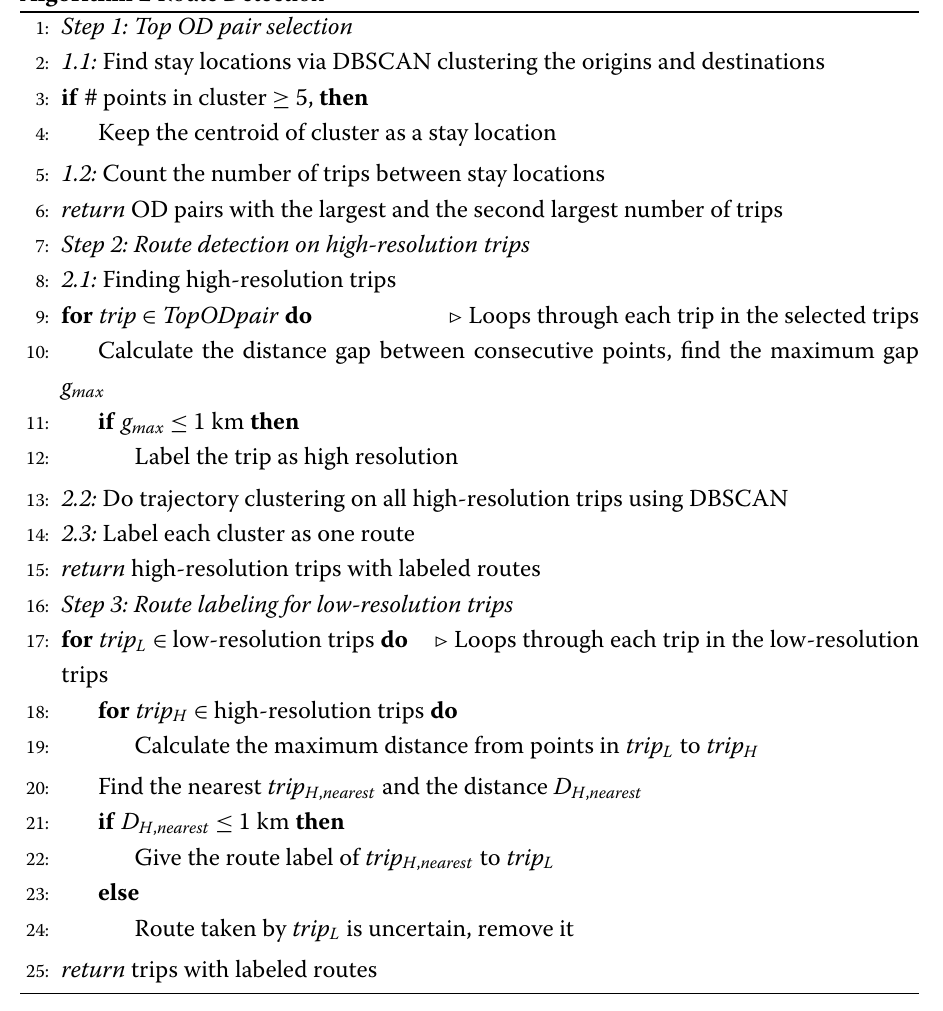
Algorithm 2 Route